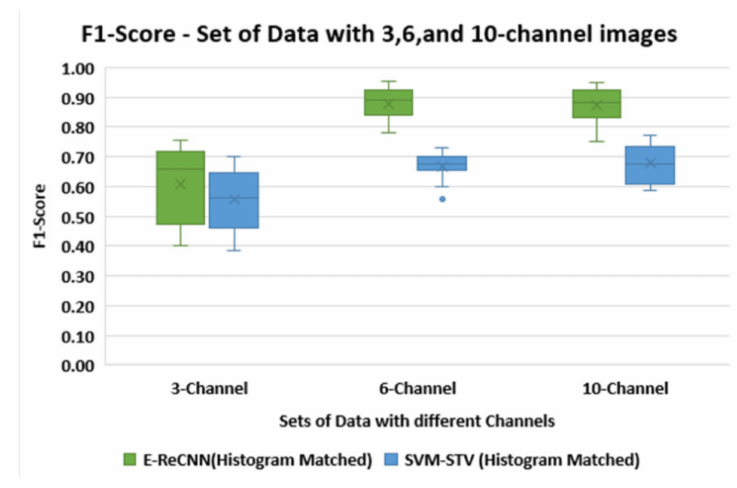
Figure 9. Analysis of multi-class results according to different numbers of channels by F1-score. Results of histogram-matched images according to 3-, 6-, and 10-Channel sets are shown based on F1-score. The E-ReCNN model results had higher accuracy than the SVM-STV model. The 6-Channel results average was more accurate and had less standard deviation than the 3- and 10-Channel